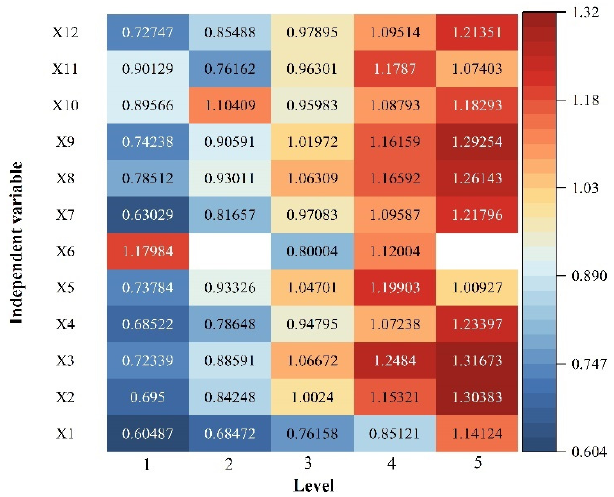
Figure 8. Risk detector results.